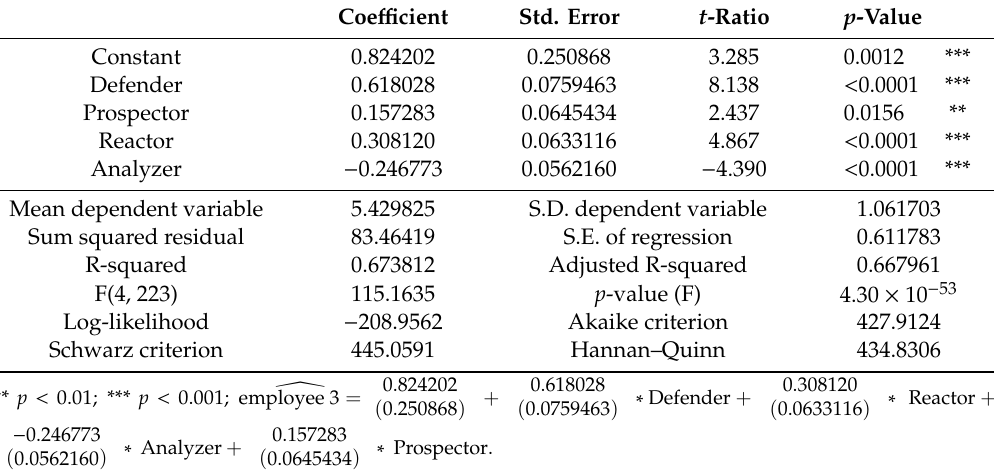
Table 11. Model 11: OLS, using observations 1–228. Dependent variable: Employee